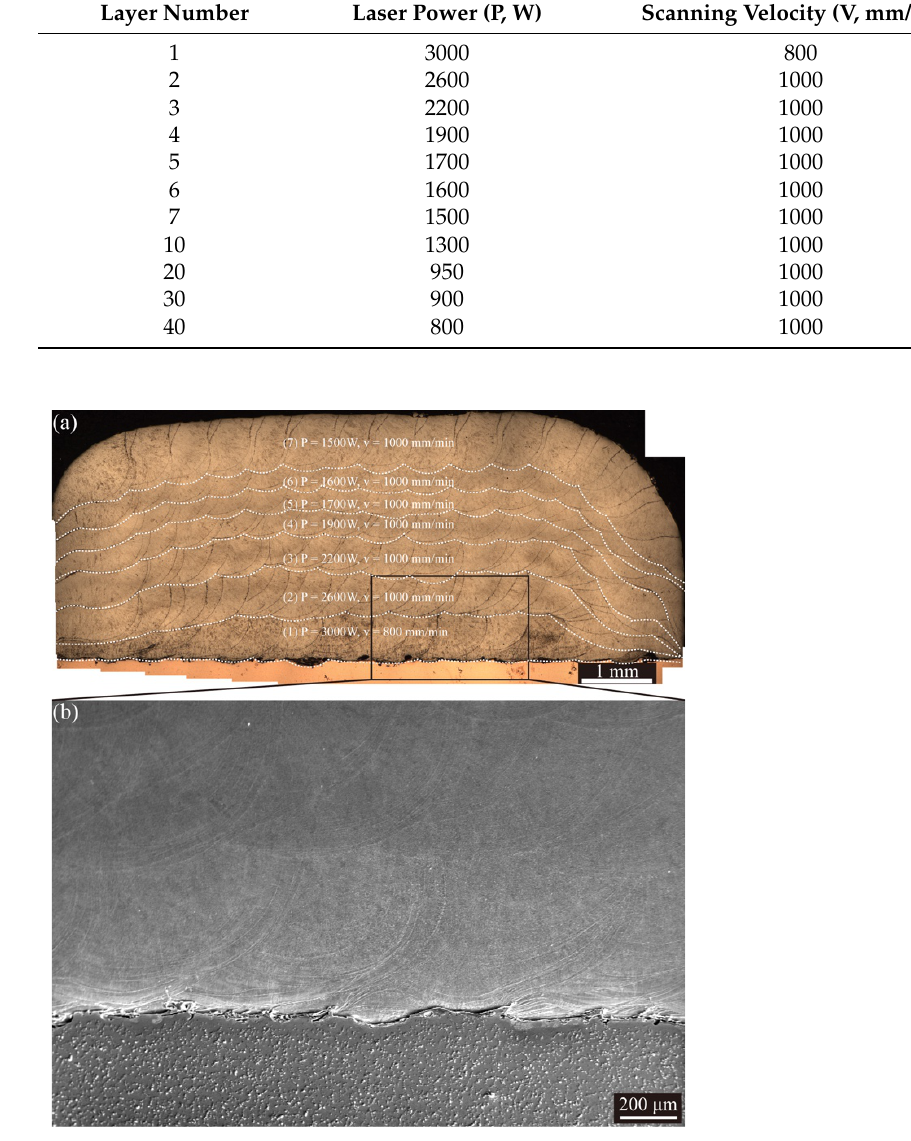
Figure 14. Cross-section morphologies of the seven-layer specimen: ( a ) overview of the cross-section; ( b ) magnified view of the copper/steel interface.